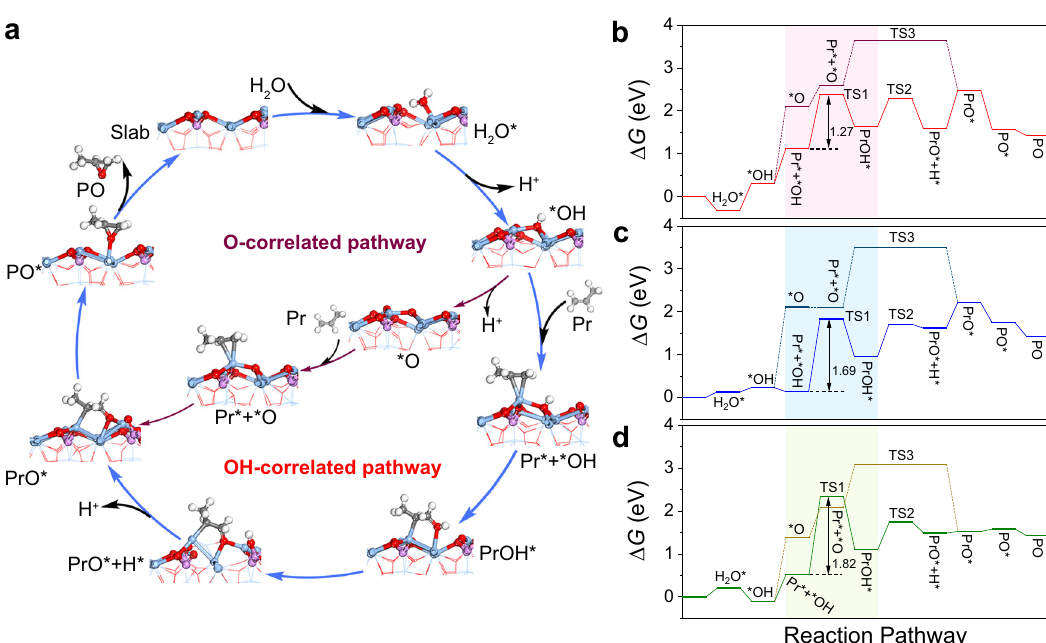
Fig. 3 Reaction paths over Ag 3 PO 4 crystals. a Scheme of the two reaction pathways on (100) facets of Ag 3 PO 4 . The gray, white, blue, red, and light pink spheres represent C, H, Ag, O, and P atoms, respectively. b Free energy diagram of electrooxidation of propylene with OH-correlated pathway (red) and O-correlated pathway (wine) on (100) facets of Ag 3 PO 4 . c Free energy diagram of electrooxidation of propylene with OH-correlated pathway (blue) and O-correlated pathway (navy) on (110) facets of Ag 3 PO 4 . d Free energy diagram of electrooxidation of propylene with OH-correlated pathway (green) and O-correlated pathway (chartreuse) on (111) facets of Ag 3 PO 4 . * represents the adsorption